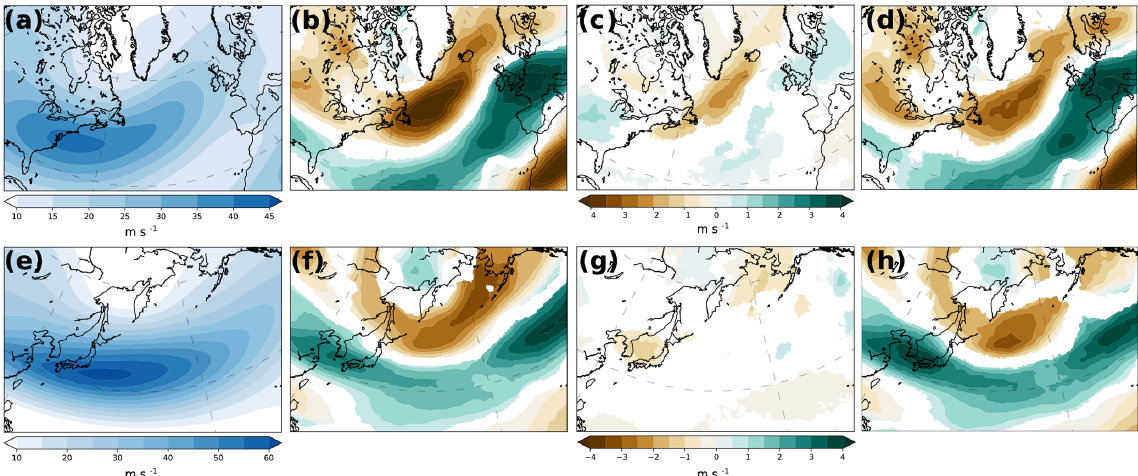
Figure 10. (a) Climatological wind speed at 300hPa (shading, ms − 1 ) for the North Atlantic for CNTL. (b) Statistically significant ( > 95%) difference of the wind speed climatology between SMTHG and CNTL (SMTHG–CNTL). (c, d) As panel (b) but separated for wind speed within (c) and outside (d) a radius of 750km around a cyclone centre. (e–h) As panels (a) – (d) but for the North